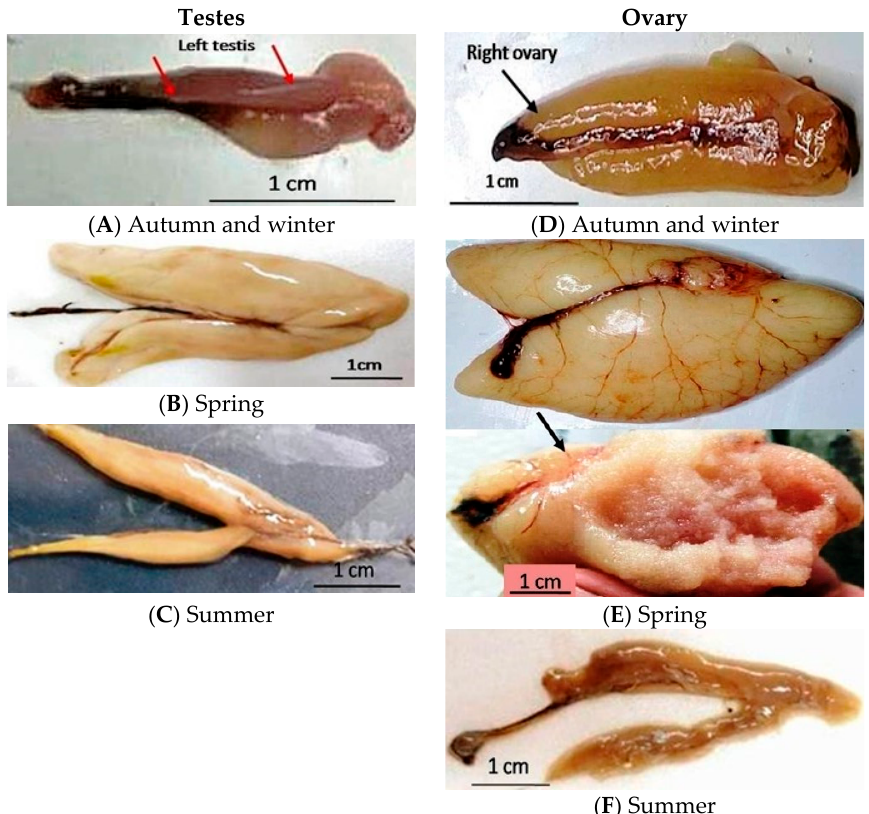
Figure 2. (A–F) : Testes and ovaries of S. rivulatus . ( A )–immature testes during the autumn and Figure 2. ( A–F ): Testes and ovaries of S. rivulatus . ( A )—immature testes during the autumn and winter, ( B )–ripe testes during the spring, ( C )–spent testes during the summer, ( D )–immature ovaries winter, ( B )—ripe testes during the spring, ( C )—spent testes during the summer, ( D )—immature during the autumn and winter, ( E )–ripe ovaries during the spring, and ( F )– spent ovaries during ovaries during the autumn and winter, ( E )—ripe ovaries during the spring, and ( F )—spent ovaries the summer. during the